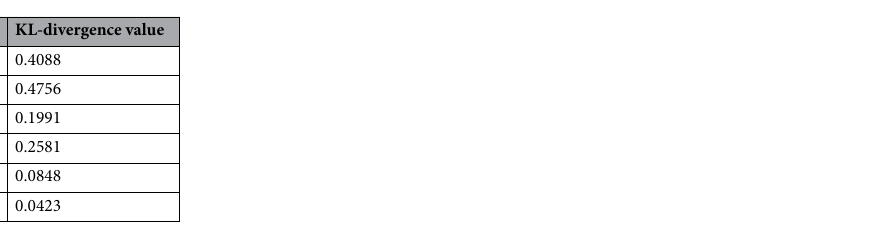
Table 1. KL divergence between ideal and actual distribution of readings for SBP and DBP of all three devices.